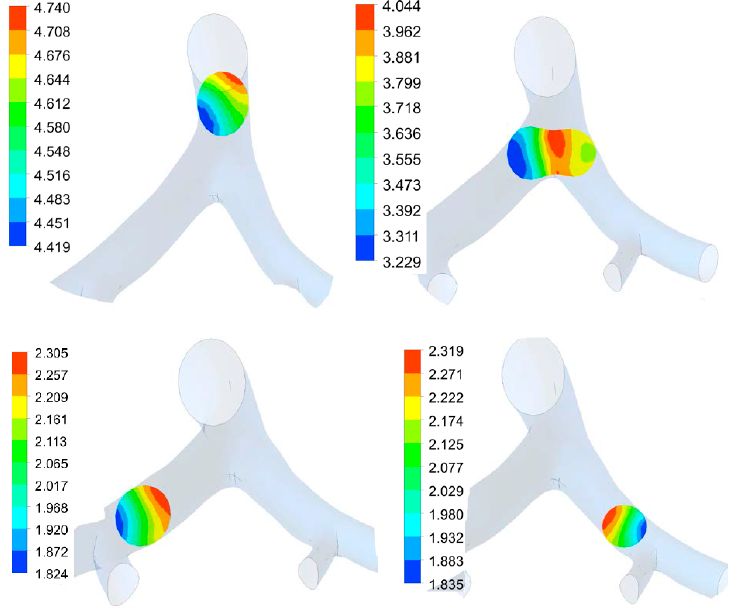
Figure 4. Pressure distribution in lung airway at several locations along airway at t = 0.3 s